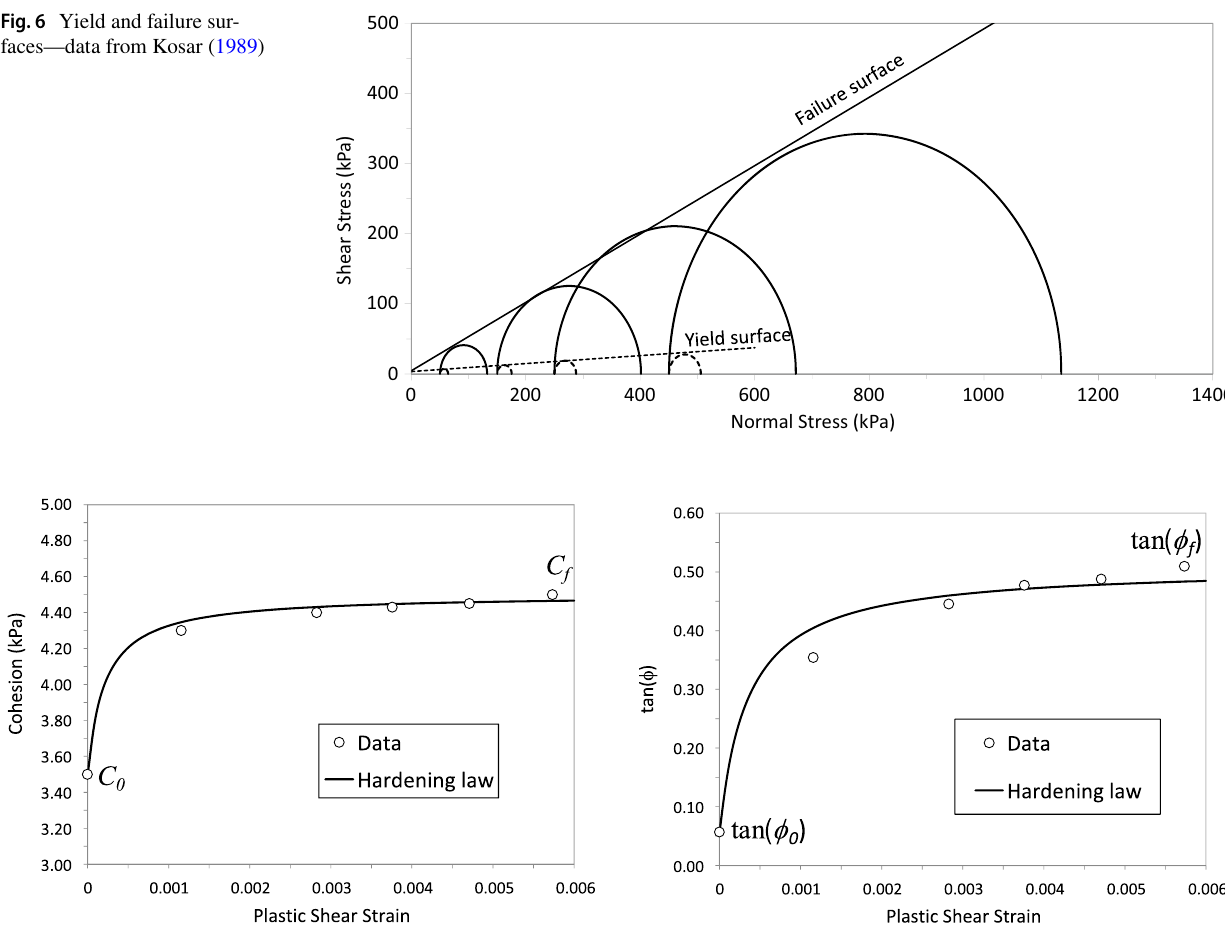
Fig. 7 Evolution of cohesion (left) and coefficient of friction (right) with plastic shear strain within the hardening phase—data from Kosar (1989)